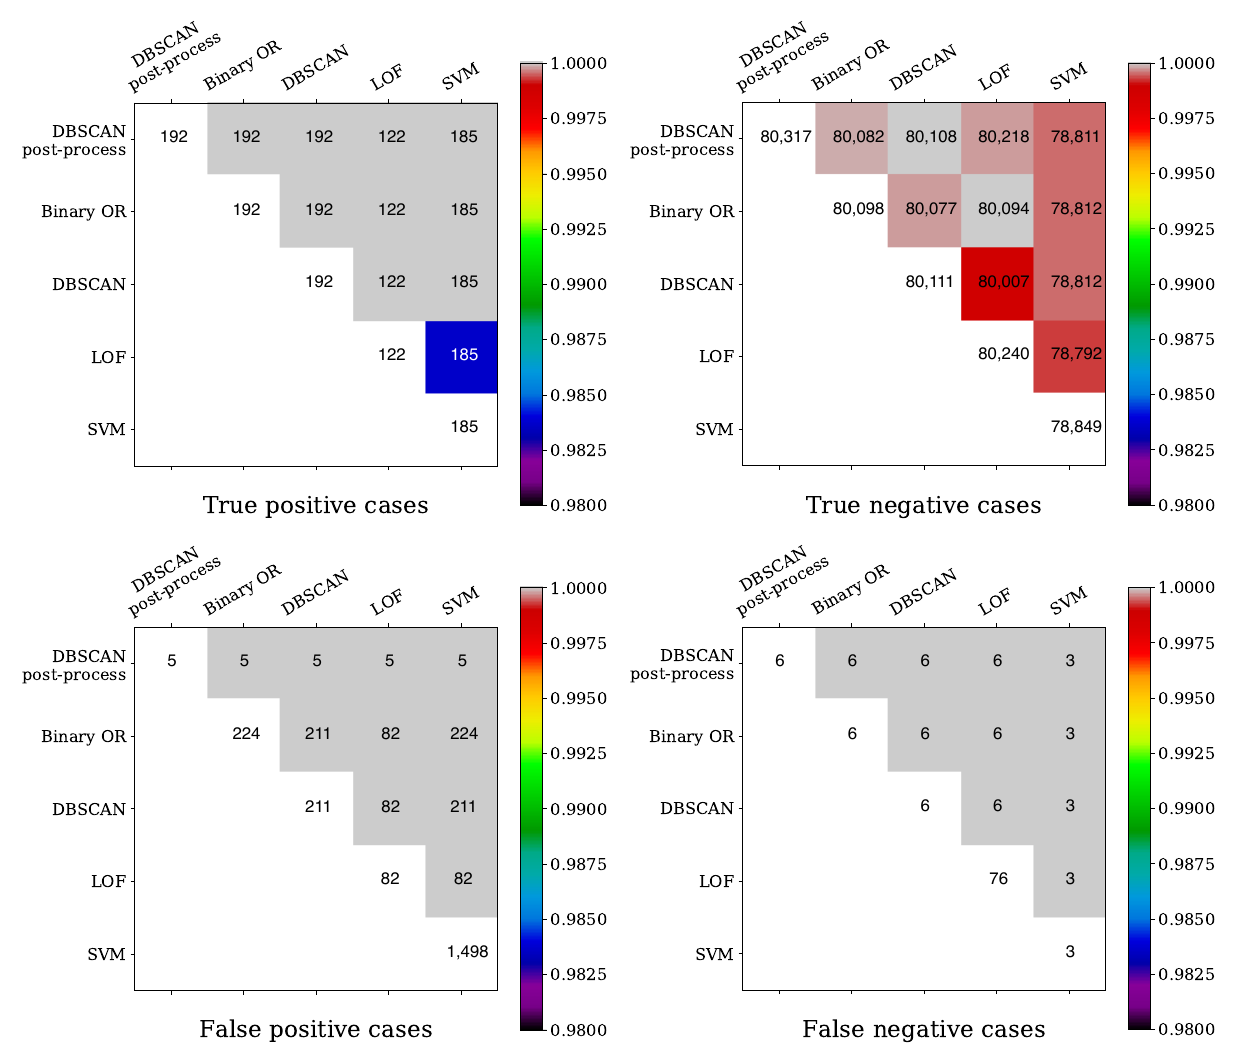
Figure 5. Detail of the TP, TN, FP, and FN cases in the form of heat maps. The number of events for the various methods are shown (along the diagonal), together with the size of the intersection (in the upper triangular cells). The normalization of the color map is provided by the minimum of the number of events for each